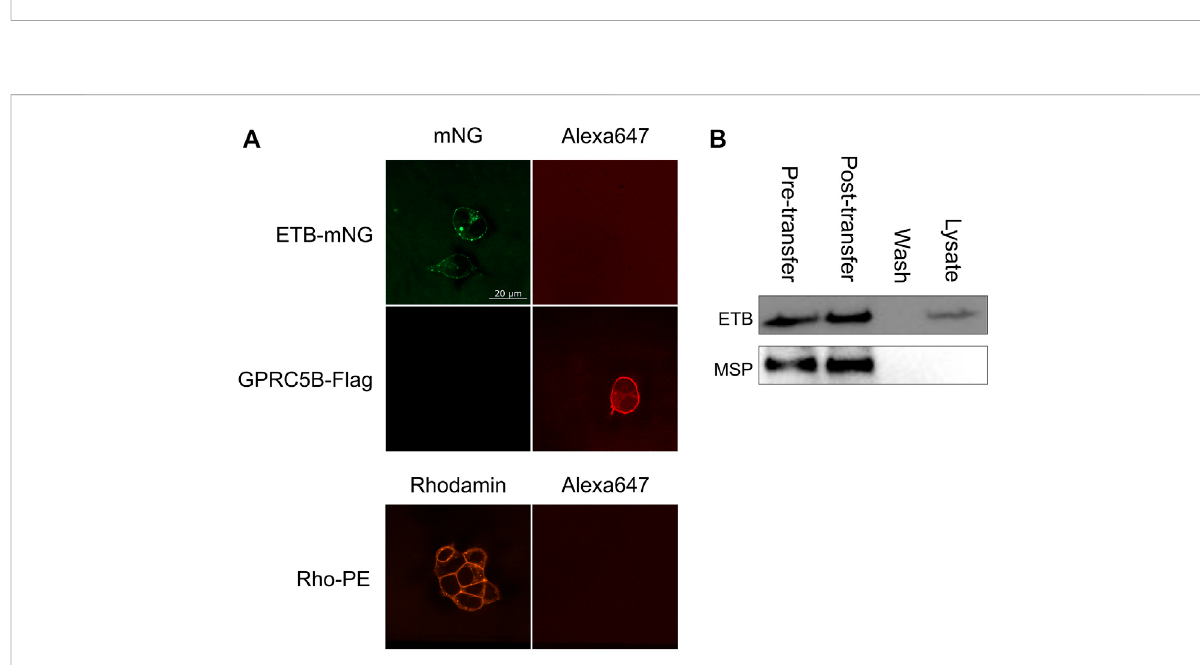
Localization ofETB-mNG and Rho-PE lipids after co-transfer into HEK293Tcells. Puri fi ed ETB-mNG/NDs(DEPG +2% Rho-PE) were incubated with HEK293T cells at standard conditions. After fi xation, the localization of transferred ETB-mNG and Rho-PE in the cells was analyzed via fl uorescence microscopy. Representative images are